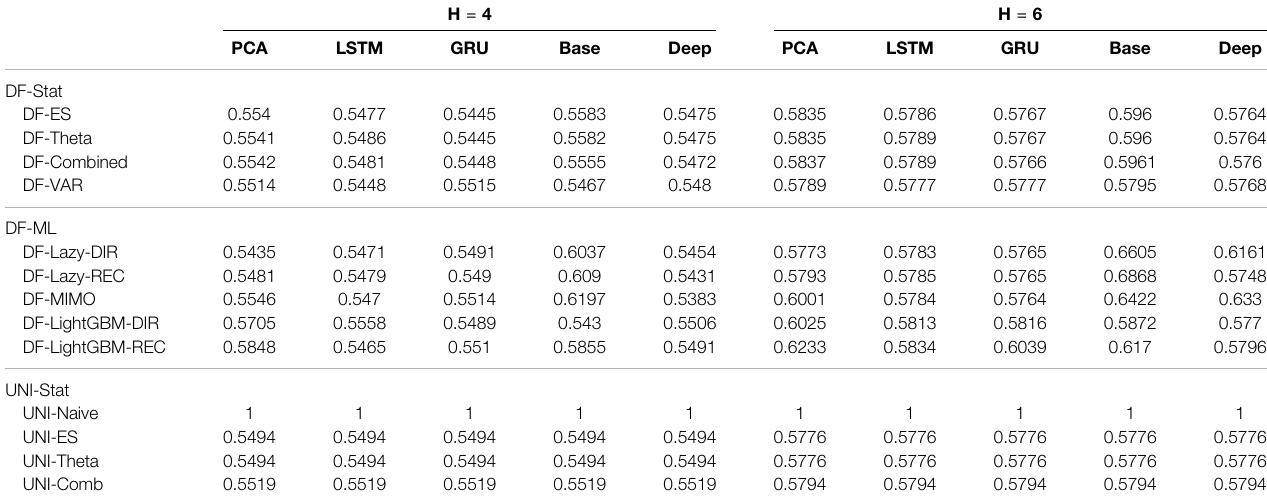
TABLE 2 | Mobility Naive Normalized MSE for H ∈ {4, 6}. The content of the cell c ij represents the model using the j th dimensionality reduction technique with the i th forecasting method. The NNMSE for the Naive method is equal to 1. An NNMSE < 1 indicates that the proposed method outperforms the Naive method. H = 4 H =